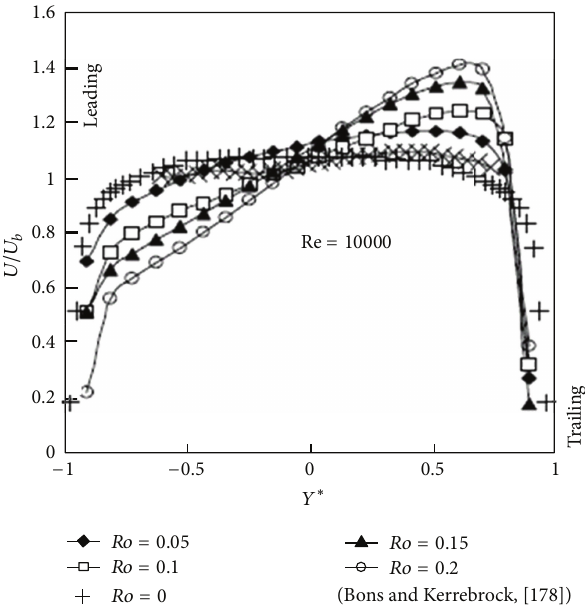
Figure 22: Midspan velocity profile for outward radial flow in a rotating smooth-walled channel from Chen and Liou